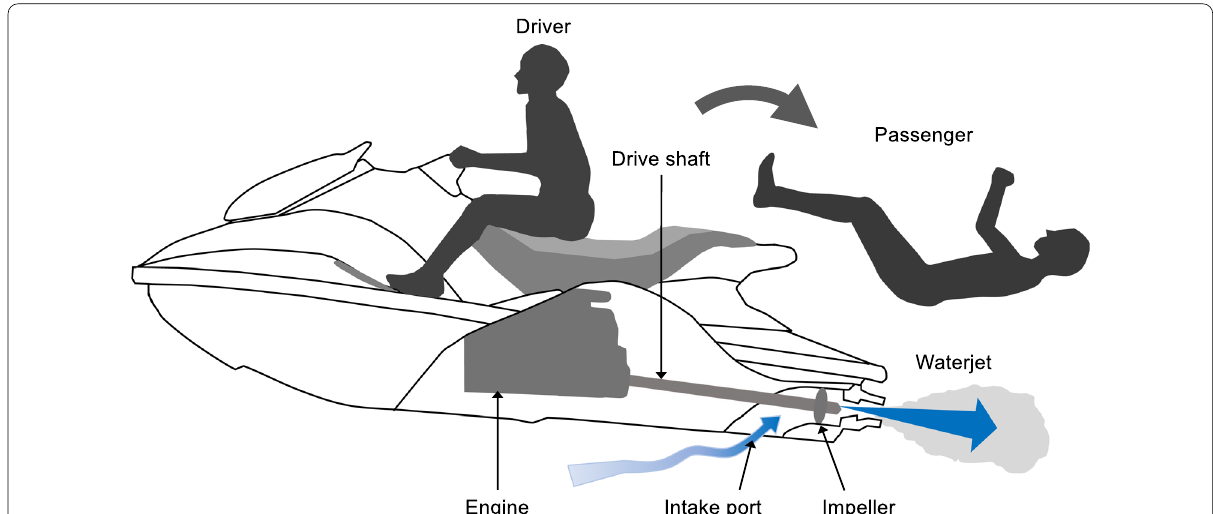
Fig. 4 A PWC has a system in which the impeller is rotated by the engine, water is taken in from the intake port at the bottom of the hull, and the water flow is accelerated by a jet pump. If riders of PWCs fall backward off of the vehicle in a supine position with their legs splayed while the throttle is still activated, the water jets of the PWC will strike the perineum